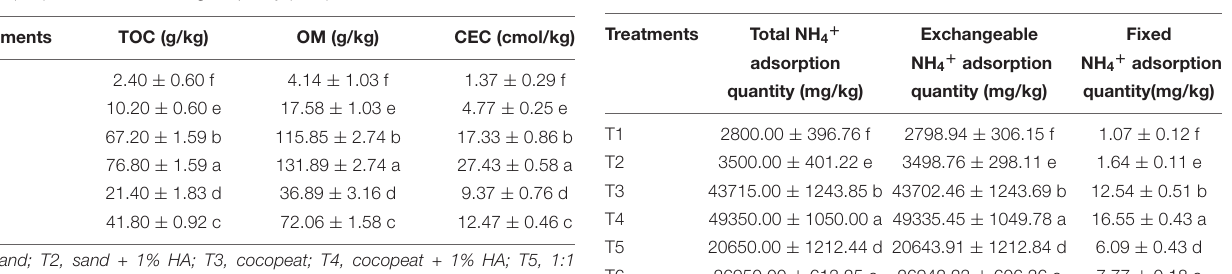
TABLE 5 | Effects of 1% HA addition on NH 4 + storage capacity of different substrates.